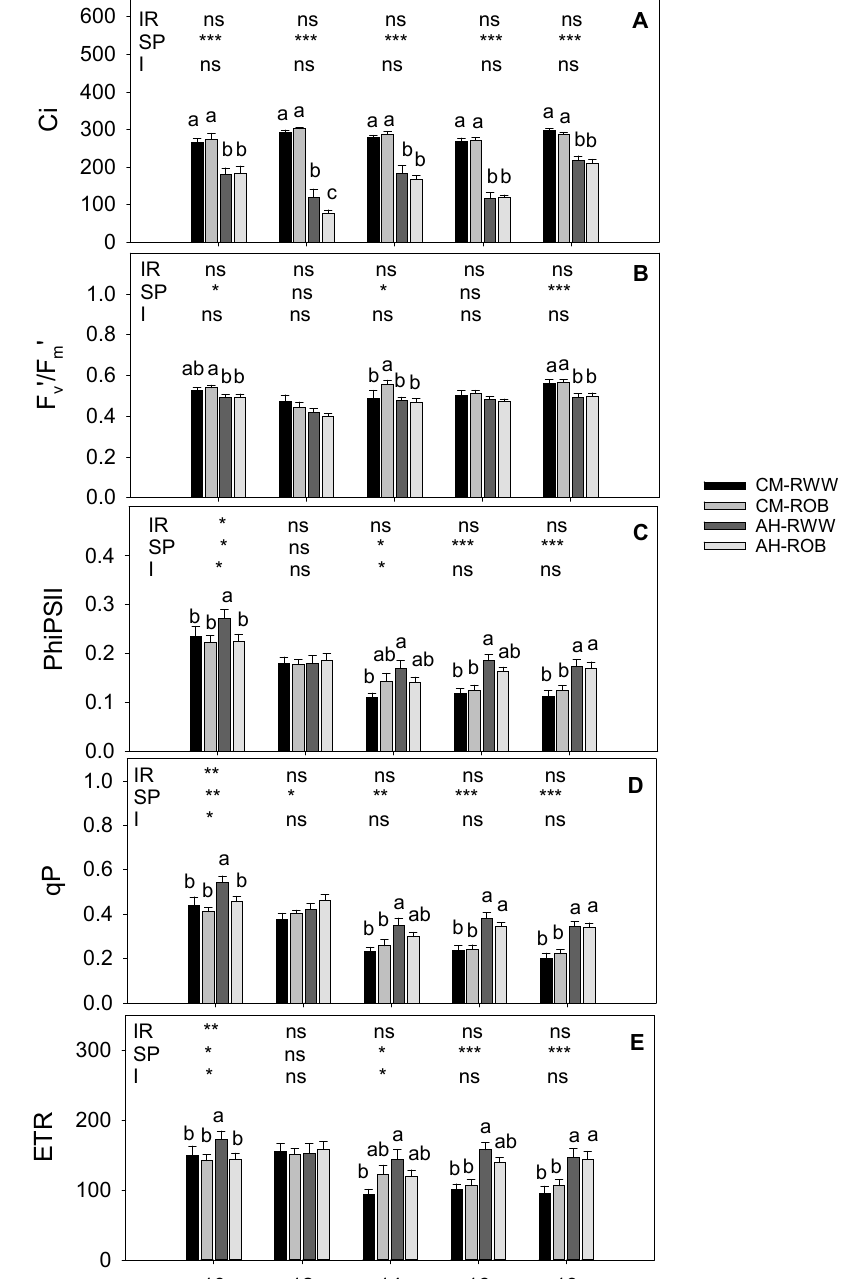
Figure 2. Internal CO 2 concentration (C i ) ( A ); The excitation capture efficiency of open centers (F v ′ /F m ′ ) ( B ); PSII effective quantum yield (PhiPSII) ( C ); Photochemical quenching coefficient (qP) ( D ); and the apparent electron transport rate (ETR) ( E ) in Crithmum maritimum (CM) and Atriplex halimus (AH) irrigated with reclaimed wastewater (RWW) and reverse osmosis brine (ROB). Results were from one way and two-way ANOVA tests in these parameters, for independent variables (irrigation, IR, and species, SP) and their interaction (I). Different lowercase letters indicate significant differences between treatments according to Duncan’s test at p ≤ 0.05. * p < 0.05, ** p < 0.01 and *** p < 0.001. p > 0.05 non-significant differences are indicated by